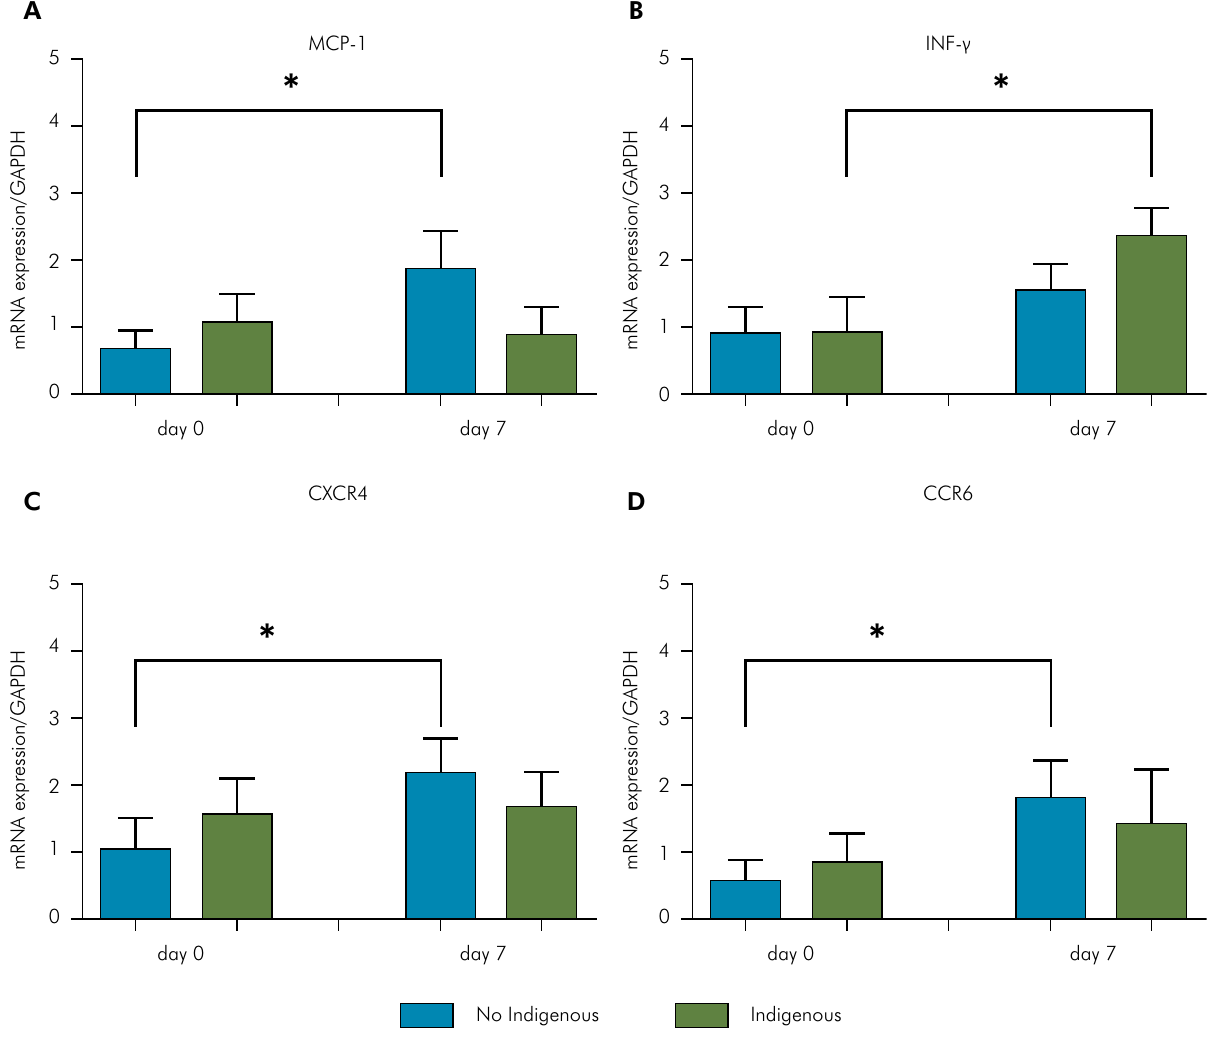
Figure 2 (a-d). Expression of MCP-1, INF- γ , CXCR4 and CCR6 genes in the periradicular tissues of indigenous and urban individuals with root canal infections. Levels of expression were determined by real-time PCR and quantified by comparison with an internal control (GAPDH). Bars represent the mean values of samples recovered from teeth that did or did not receive endodontic treatment; lines represent the standard error of the mean. *p < 0.05 by Wilcoxon or Mann–Whitney